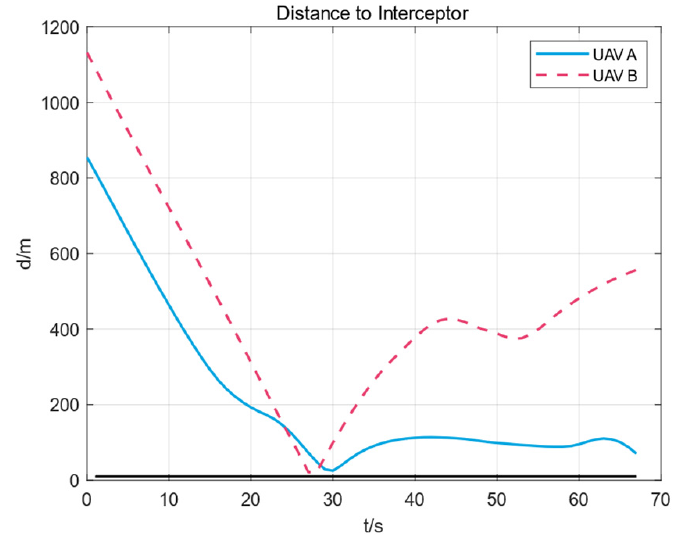
Figure 10. The distance between the UAV and the interceptor. It can be seen from the figure that the minimum distance between the two UAVs and the interceptors is above the black line, that is, they are not captured by the interceptors. Figure 11 is the distance between the two UAVs and the target point. In the figure, there is a certain gap between the initial distance between the two UAVs and the target area, which is about 10